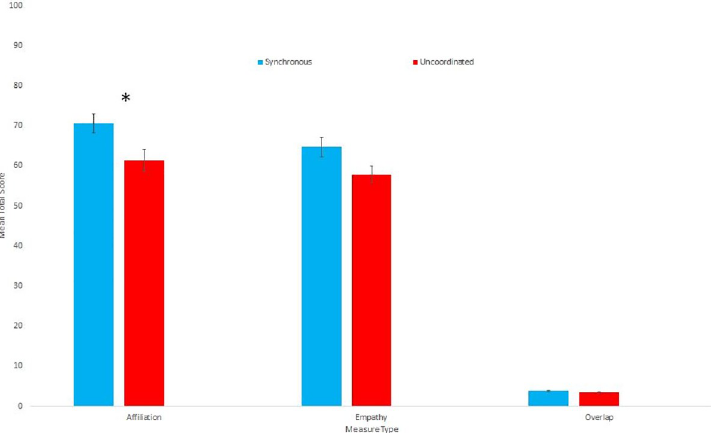
Fig 1. Means and standard errors for the Affiliation, Empathy and Overlap ratings towards the confederate.